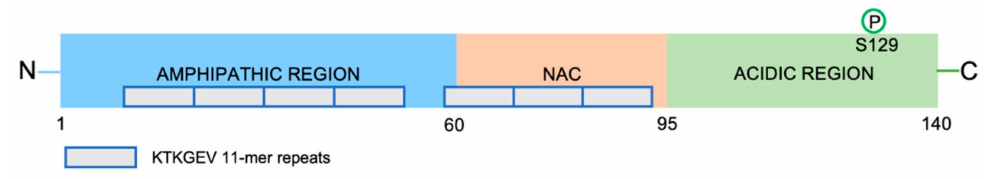
Figure 3. Schematic representation of the secondary structure of the protein α